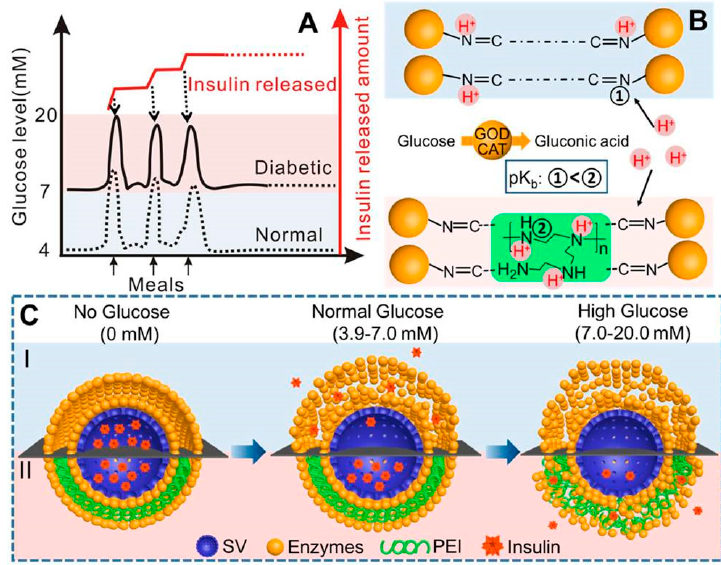
Figure 4. ( A ) Ideal insulin-release behavior under different blood glucose levels. The black dashed and solid curves correspond to the blood glucose level fluctuation in one day in healthy nondiabetic and diabetic humans, respectively; ( B ) the mechanism of glucose-responsive insulin release in the enzyme system (up, blue area) and enzyme − PEI system (bottom, pink area); ( C ) comparison between (I) traditional glucose-responsive insulin release systems where insulin would be released under normal glucose levels, and (II) physiological glucose-responsive systems, which release insulin only under “diabetic” glucose levels (reproduced with permission from [80], Copyright 2017, American Chemical Society).